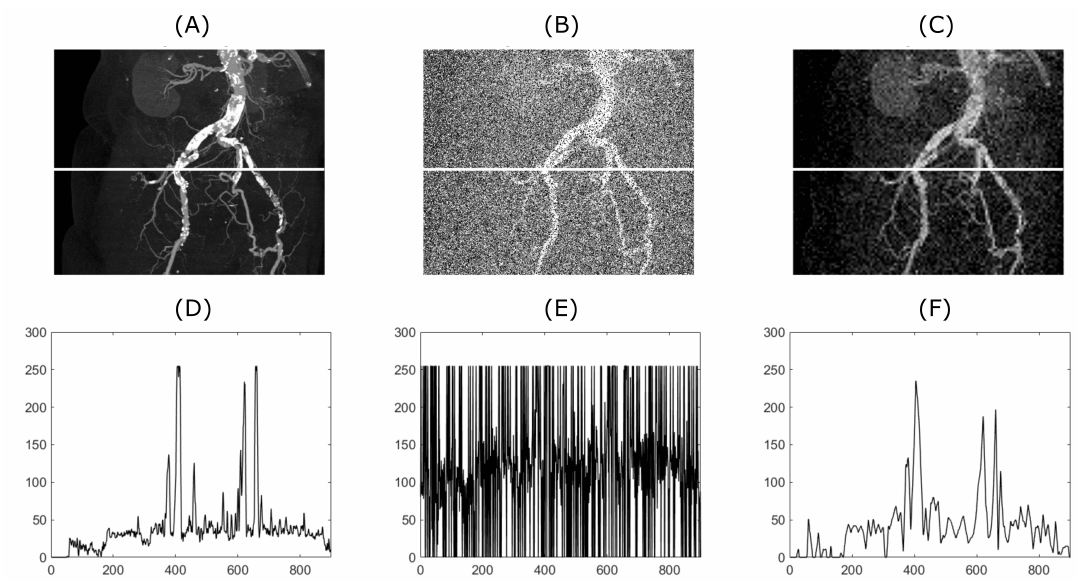
Figure 4. From ( A ) to ( C ), the upper row shows the original image, the image with added artificial noise and the image denoised by the described algorithm. As an input image, a CT scan shown in Figures 1 and 2 was used. The lower row ( D–F ) shows plots corresponding to the white line drawn in the images depicted in the upper